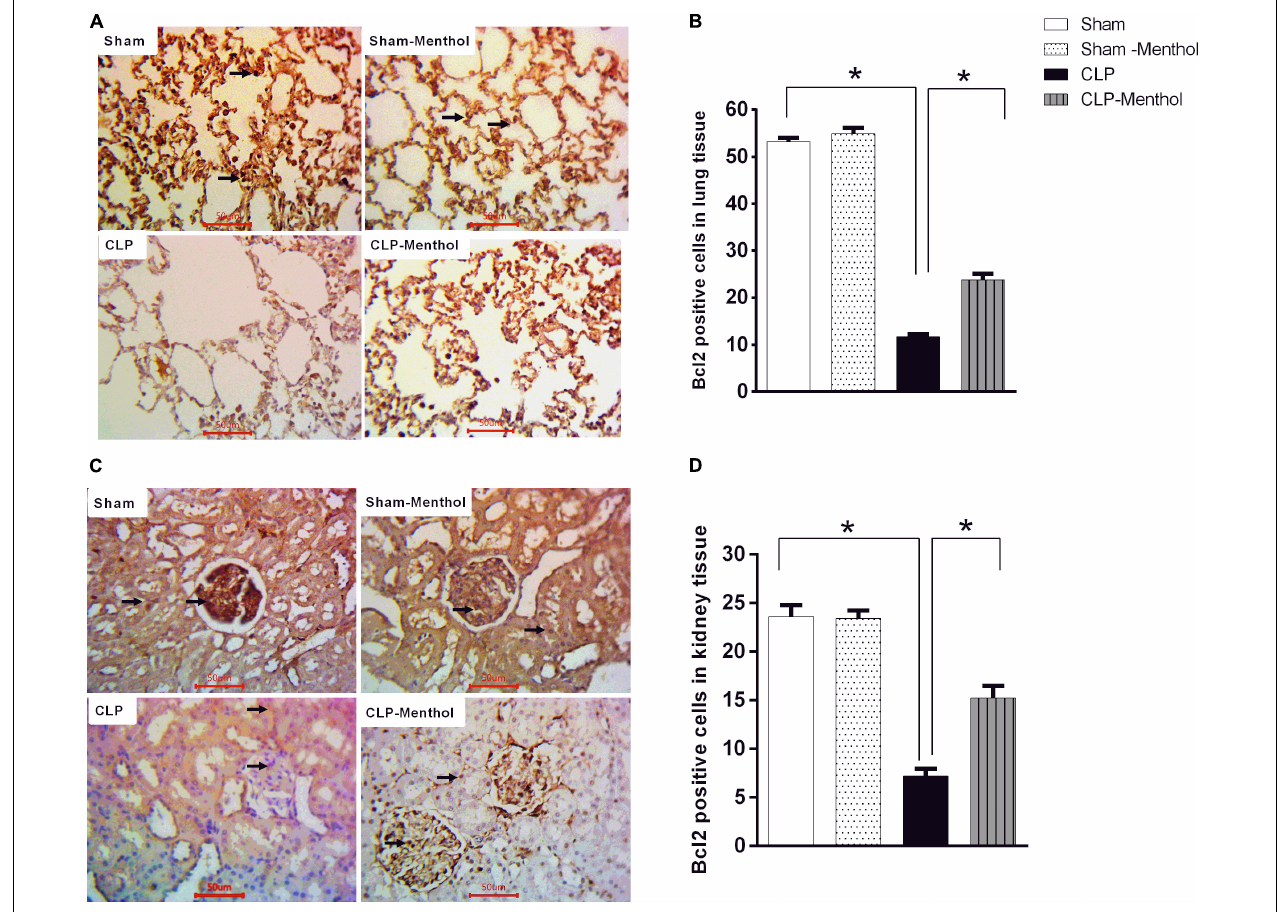
FIGURE 8 | Bcl-2 expression in the lung and kidney tissues in different groups. Protein expression of Bcl-2 was achieved by immunohistochemical staining of paraffin-embedded lung (A) and kidney (C) sections was carried out after probing the sections with rabbit polyclonal anti- Bcl-2 (cat. # ab194583, Abcam, Cambridge, United Kingdom). The mean surface area fraction of Bcl-2 immuno-positive cells form images (400X) was measured using ImageJ software. Representative photomicrographs (A) showing the effect of menthol treatment on Bcl-2 immunoreactivity in lung tissues. A semi-quantitative analysis of the immunostaining data from ten random fields per slide from each group ( n = 6) is depicted in (B) . Data of Bcl-2 immunoreactivity in the kidney sections from different groups are semi-quantitatively analyzed in (D) . Data represent the mean ± SEM of 6 independent observations. Data were analyzed by one-way ANOVA followed by the Tukey-Kramer post- test for multiple comparisons. *Significantly different at p < 0.05 compared to the CLP